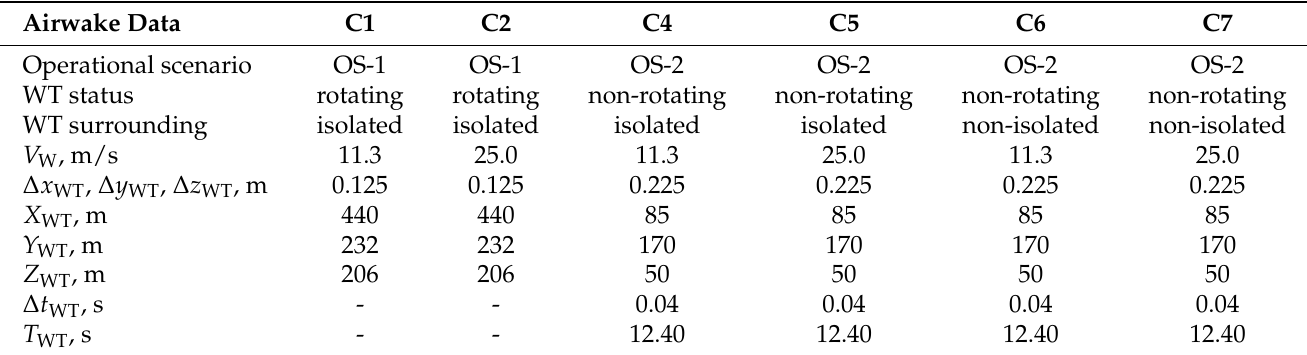
Table 1. Overview of interpolated airwake